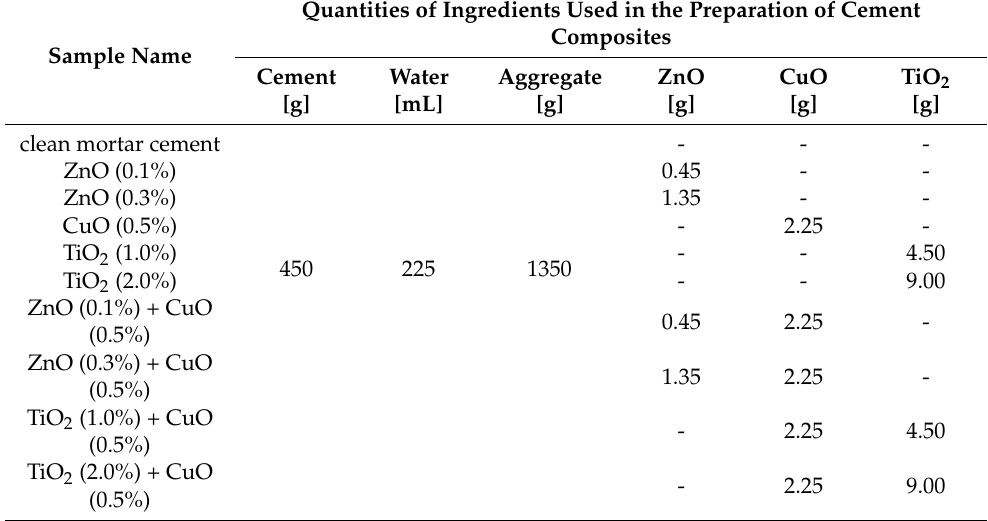
Table 1. The composition of the mixtures used to prepare the appropriate cement